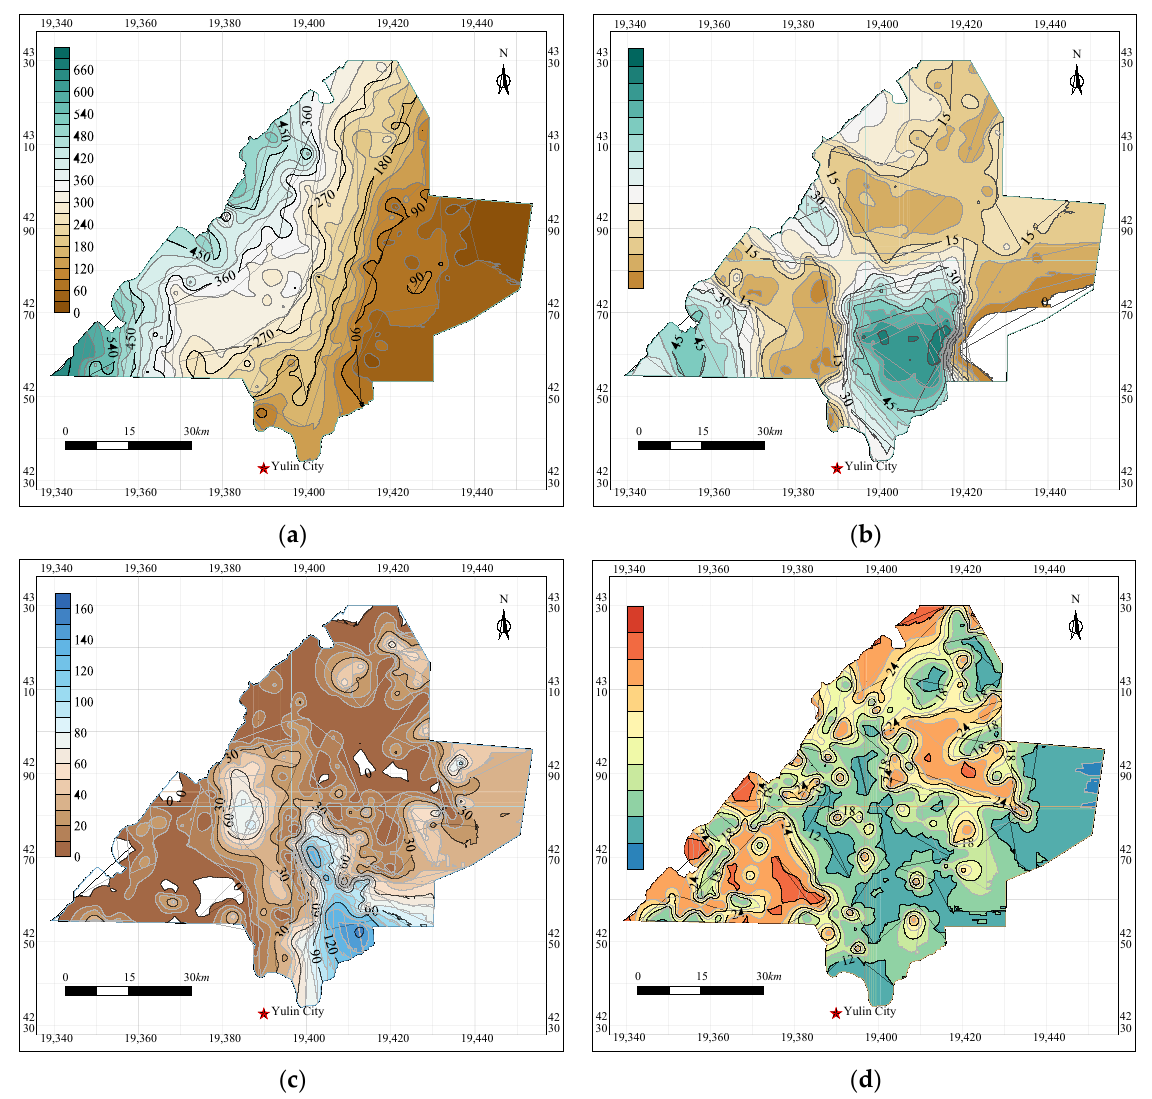
Figure 9. Thematic maps of the BRW system. ( a ) contour map of the distance from the overlying aquifer to the first-mined coal seam; ( b ) contour map of the height of the water conducting fractured zone; ( c ) contour map of the thickness of the aquifuge; ( d ) contour map of the thickness of the protective zone.